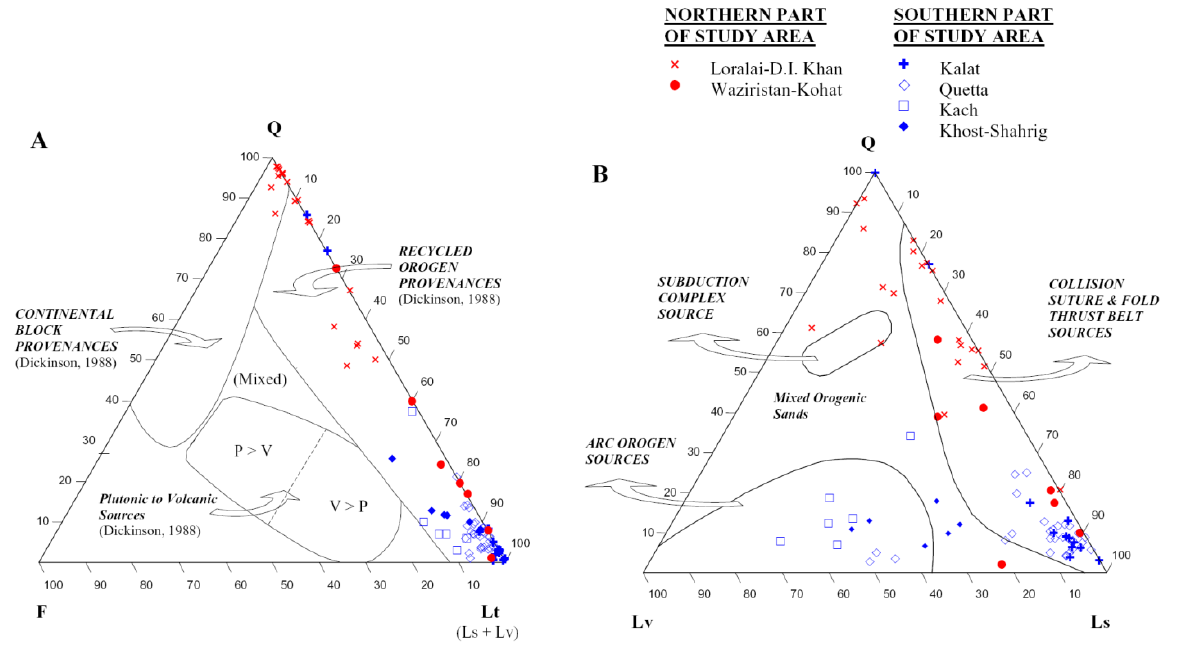
Figure 5. Distribution of detrital modes for upper Paleocene-lower Eocene sandstone rocks of the study area are plotted on standard ternary diagrams with overlays of provenance classification [112]. Results show that the Ghazij is dominated by recycled orogen, collision suture and fold thrust belt sources. ( A ) Standard modal composition of quartz, feldspar and rock fragments (QFL) for sandstone rocks separated by geography; ( B ) Relative abundance of rock fragment types for sandstone rocks separated by geography (see also Tables 1 and S2). Q, quartz; F, feldspar; Lt, total lithic fragments; Ls, sedimentary lithic fragments; Lv, volcanic lithic